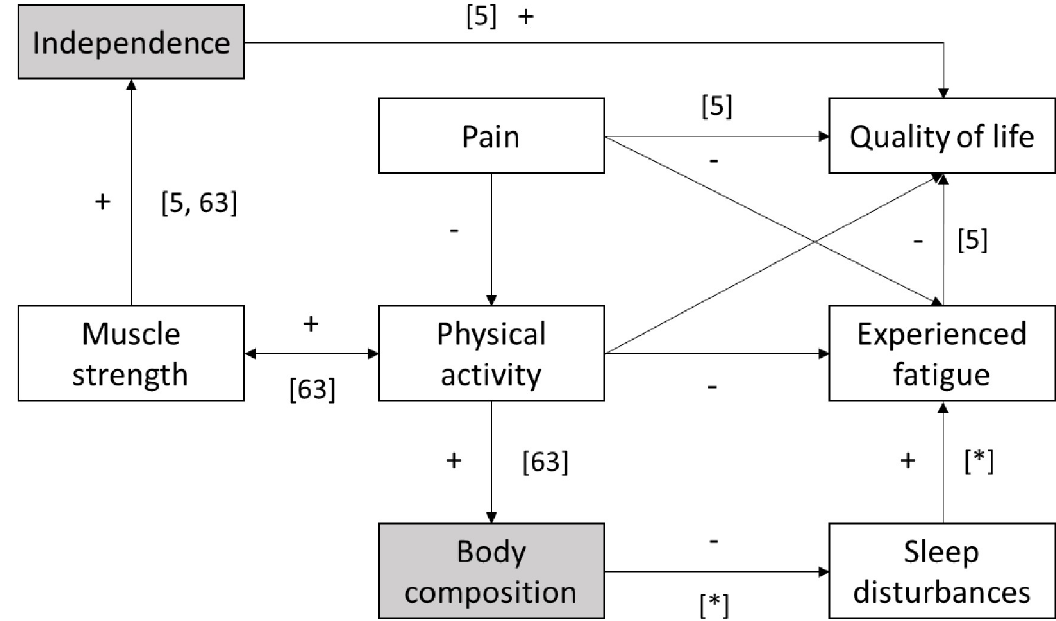
Fig 2. Proposed health model for adults with muscular dystrophy, adapting the previous work from de Groot et al. [11] (White Boxes), added new components (Grey Boxes), using the present study (Denoted by [ � ]) and the authors previous findings [5, 63]. Increases/improvements or decreases/impairments are denoted by + or–signs, respectively.